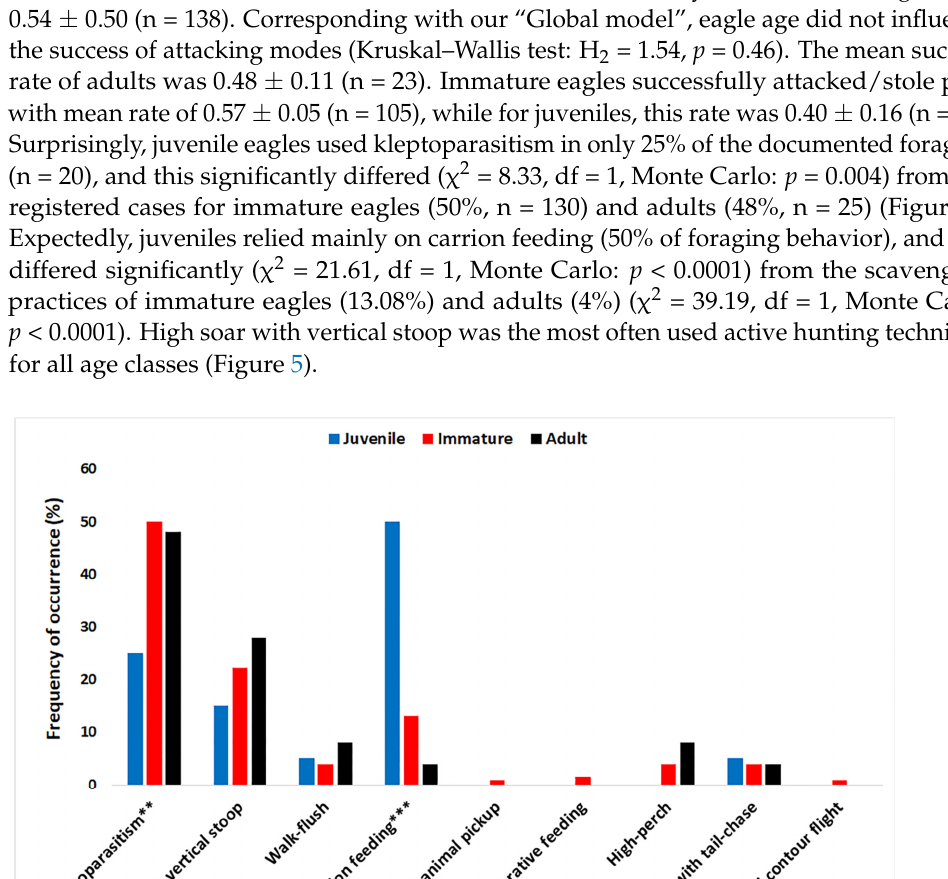
Figure 4. Frequency of occurrence (%) of different prey types used by non-territorial Eastern Imperial Eagles in different seasons. Significant values are given in *.